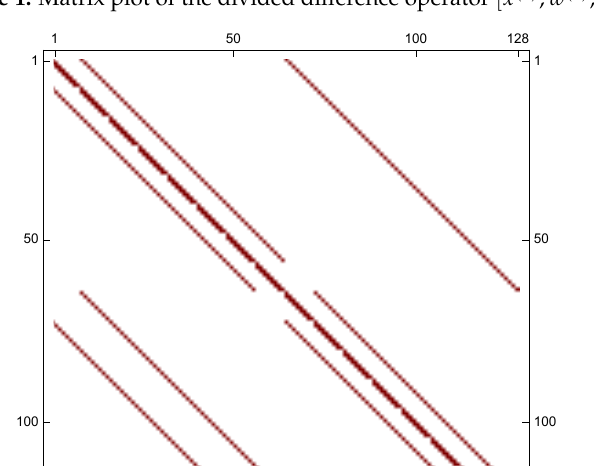
Figure 2. Matrix plot of the divided difference operator [ x ( k ) , z